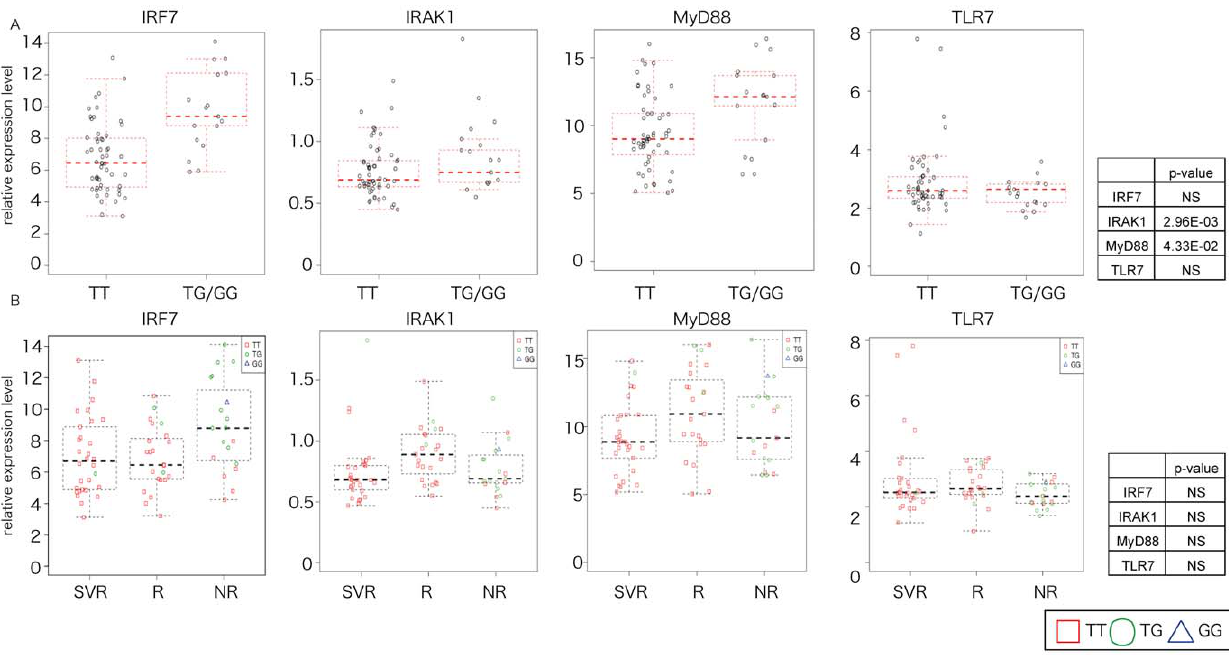
Figure 4. The relationship between the expression level of genes which participate in IFN production (TLR7, MyD88, IRAK1, and IRF7) in the liver of CH patients and IL28B genotype. (A) The relationship between IFN early response genes and clinical outcome is shown. A summary table of the p-value is also presented. NS shows no significant difference. (B) The relationship between IFN early response genes and IL28 genotype is shown. The p-value is also presented.